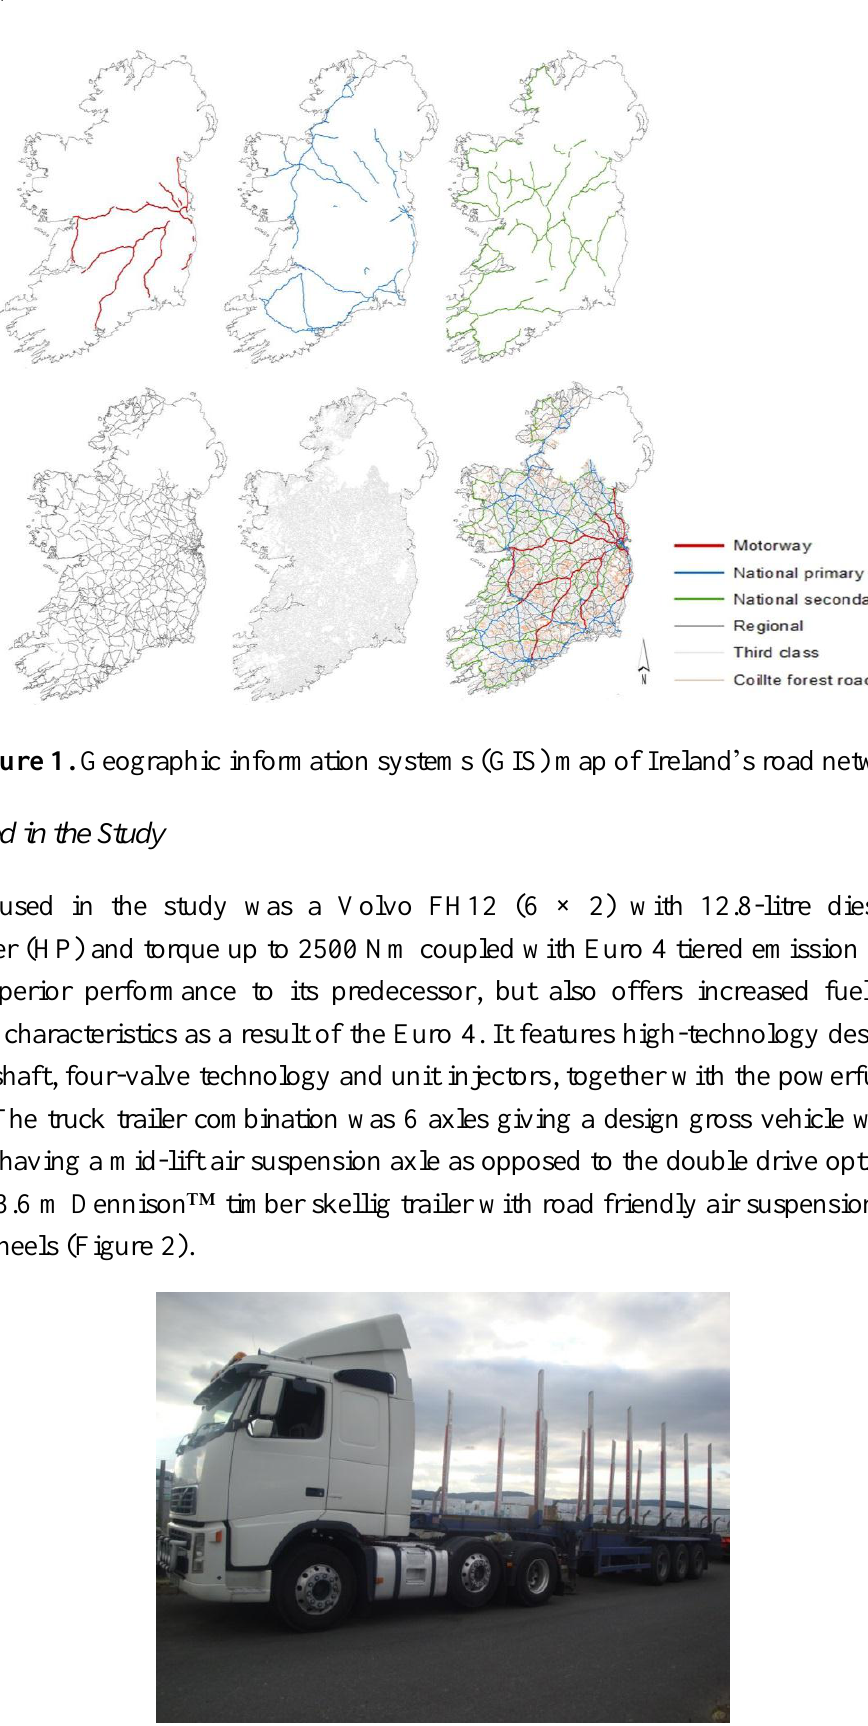
Figure 2. Volvo FH12 Truck used in the